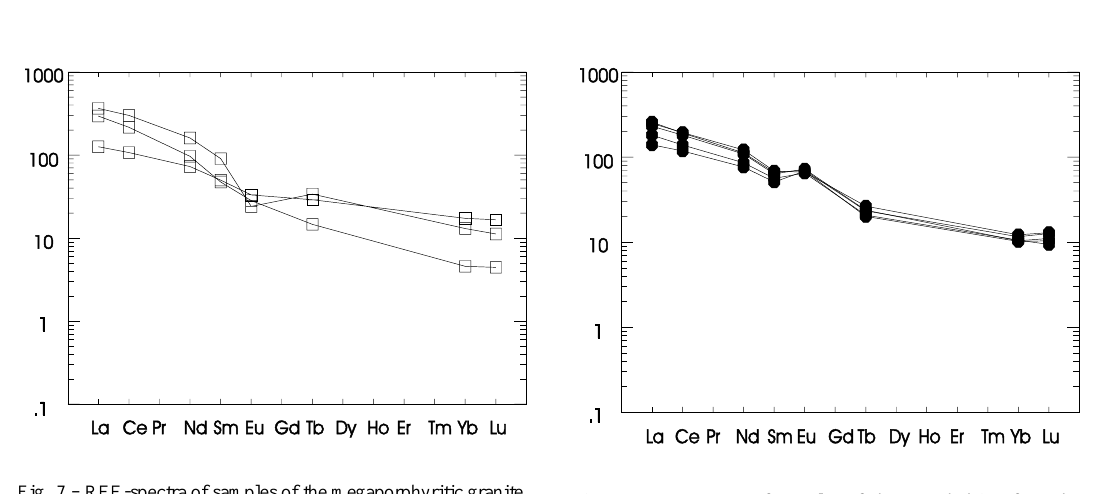
Fig. 9 – REE-spectra of samples of charnoenderbites from the outer domain. Normalization after Boynton (1984). Explanation in text.